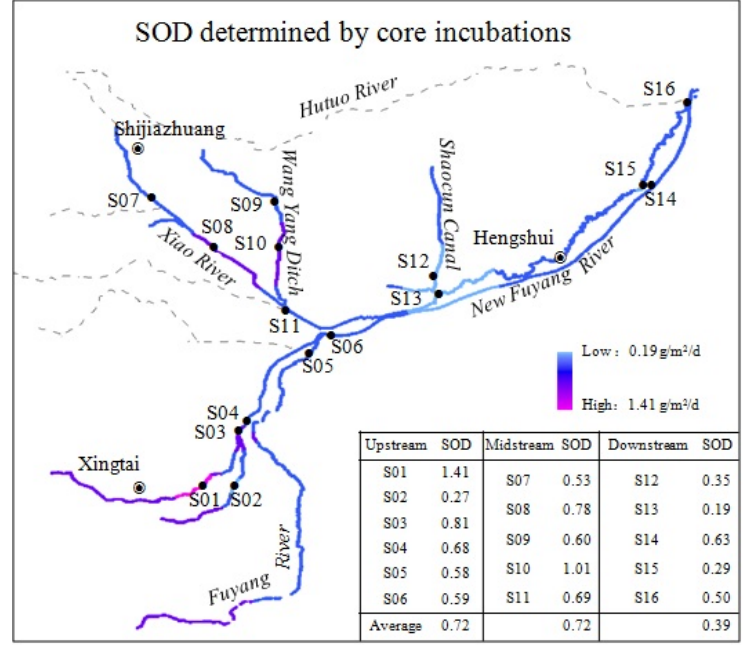
Figure 3. Spatial variations of the sediment oxygen demanddetermined by laboratory core incubations in the Ziya River Watershed.